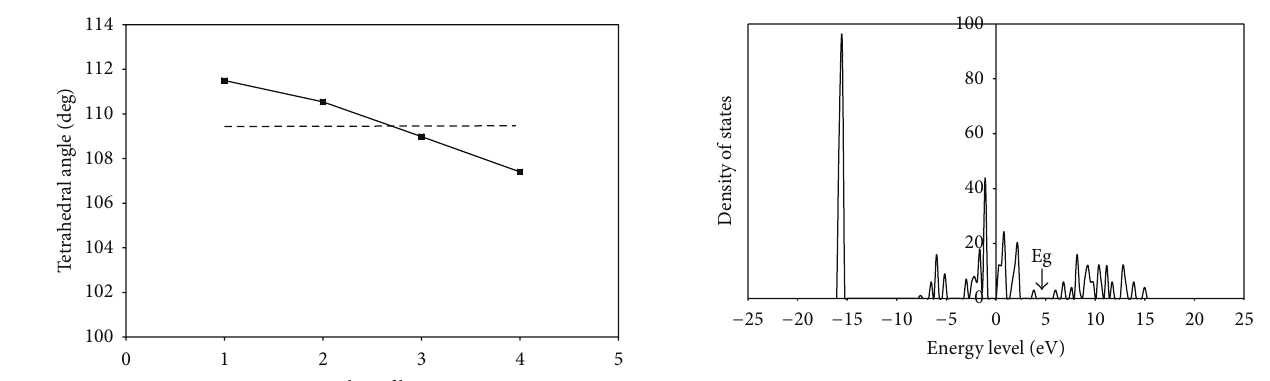
Figure 9: Density of states of InSb 64-atom LUC as a function of energy